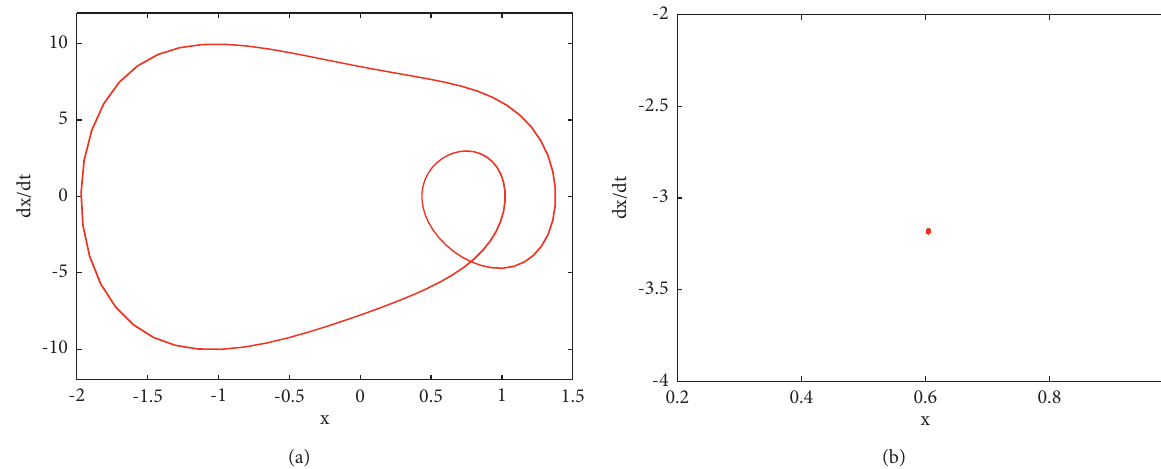
Figure 13: Phase portrait, time history, and Poincar´e cross section diagram of the system at F � 37.70 and τ � 0.8. (a) Phase portrait. (b)